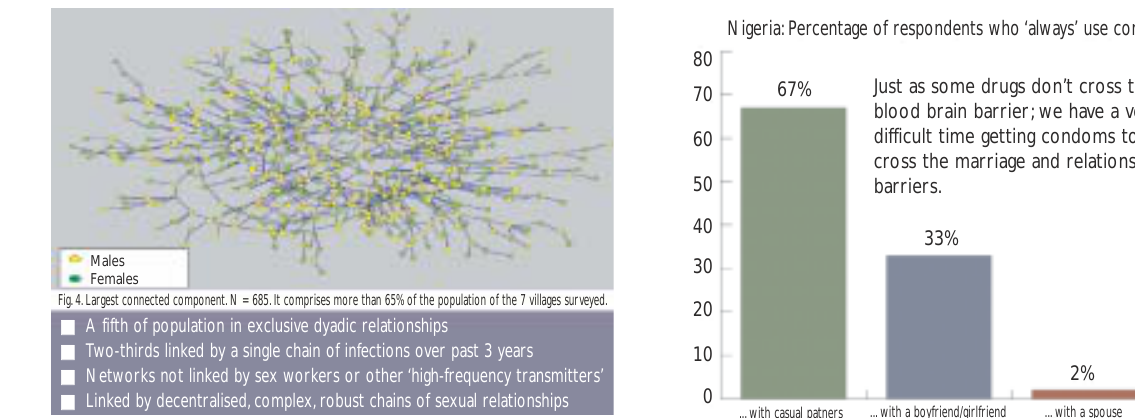
Fig.4.Largest connected component.N = 685.It comprises more than 65% of the population of the 7 villages surveyed. ■■ A fifth of population in exclusive dyadic relationships ■■ Two-thirds linked by a single chain of infections over past 3 years ■■ Networks not linked by sex workers or other ‘high-frequency transmitters’ ■■ Linked by decentralised,complex,robust chains of sexual relationships Fig. 4. Sexual networking in Likoma, Malawi.